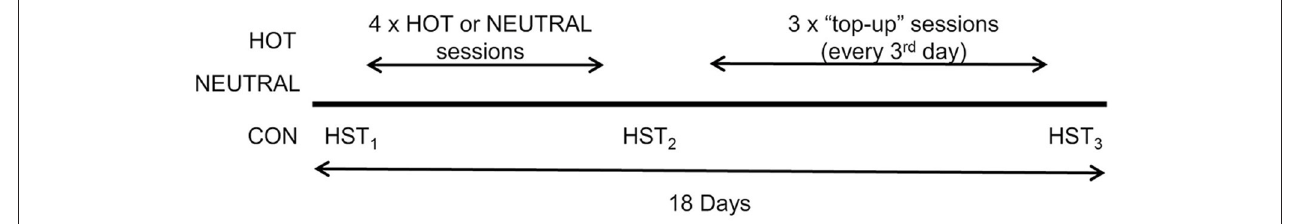
FIGURE 1 | Study timeline for Heat Training (HOT), Thermo-neutral Training (NEUTRAL), and Control (CON) groups.